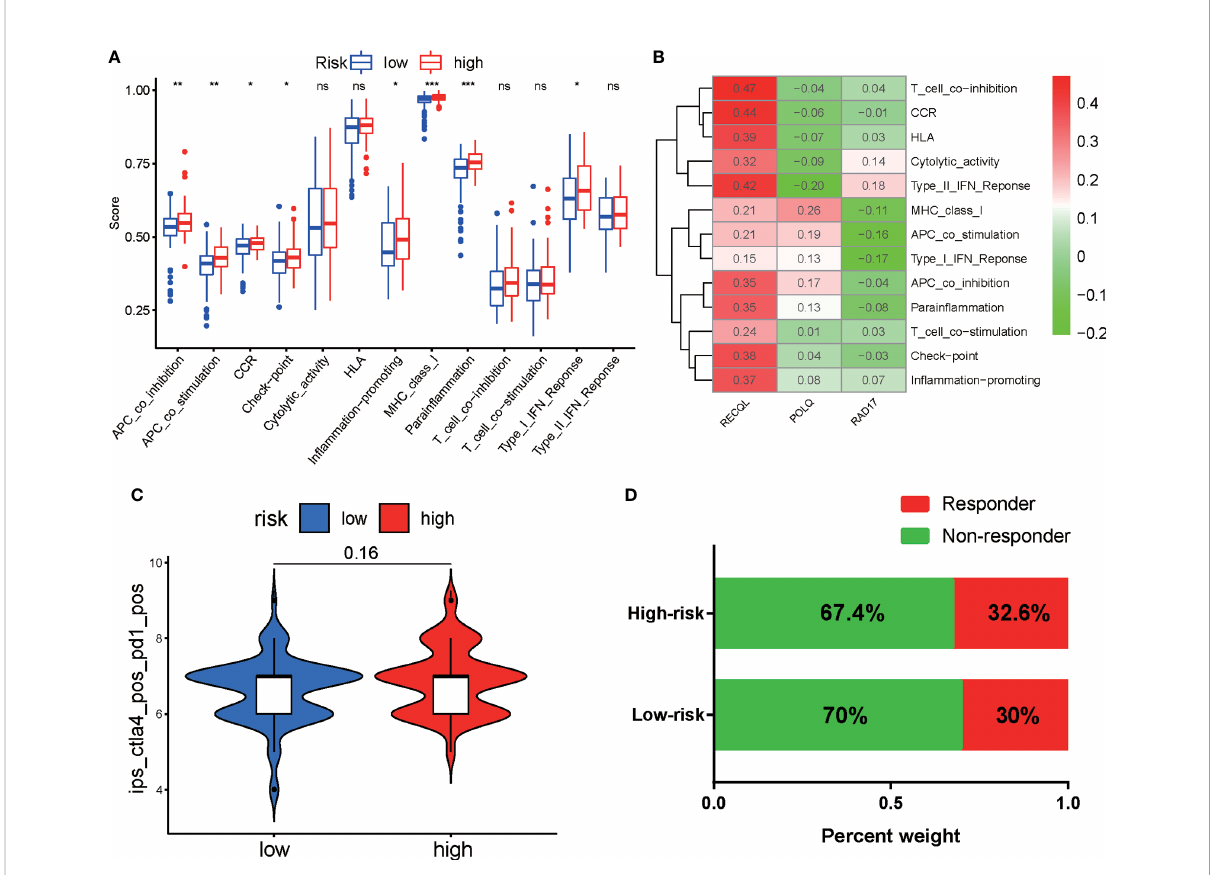
FIGURE 8 Correlation analyses and evaluation of immunotherapy sensitivity in the two risk groups of PAAD patients. (A) Correlation analyses of immune- related functions in the high-risk and low-risk groups of PAAD patients. (B) Correlation analyses of the expression of three DRGs and immune- related pathways. (C) Violin plot showing the IPS for CTLA-4 and PD-1 inhibitors between the two groups based on the TCIA database. (D) Comparison of the responses of the two groups to immunotherapy using the ImmuCellAI algorithm. * p < 0.05, ** p < 0.01, *** p < 0.001. ns, not signi fi